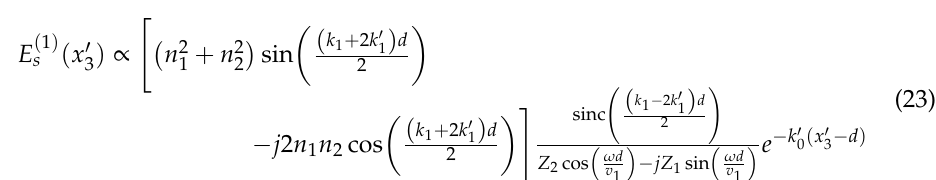
Table 1. Physical quantities of the PMMA layer and Si substrate used in the theoretical calculations. Mass density ( ρ ), sound velocity ( v ), photoelastic constant ( p 12 ) and refractive index ( n ). Material p (Kg/m 3 ) v (m/s) p 12 n PMMA 1150 2778 0.3 1.4932 Si 2335 8431 0.01 3.5 −